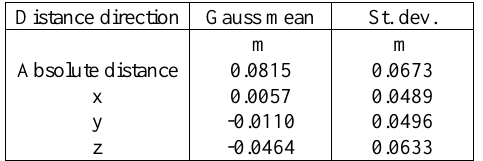
Table 2 . Values obtained after the application of the Cloud-to- Cloud tool between DJI Phantom 4 clouds (compared) and DJI Matrice 300 RTK P1 (reference), without the application of Cloud registration.